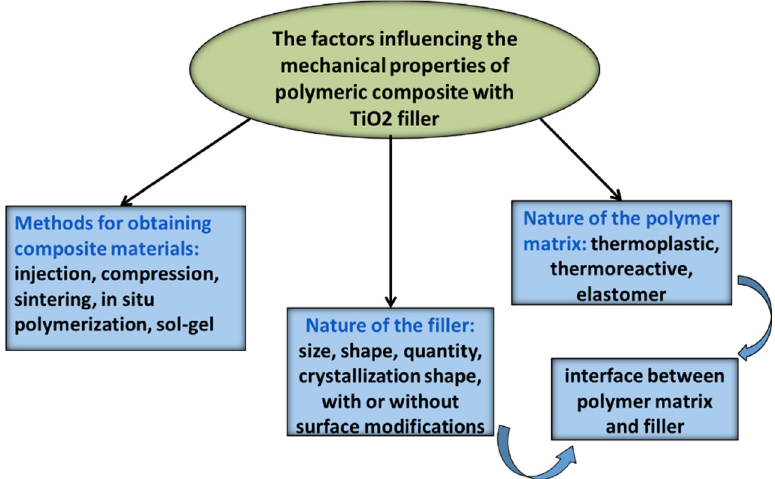
Figure 4. The factors that influence the mechanical properties of composites